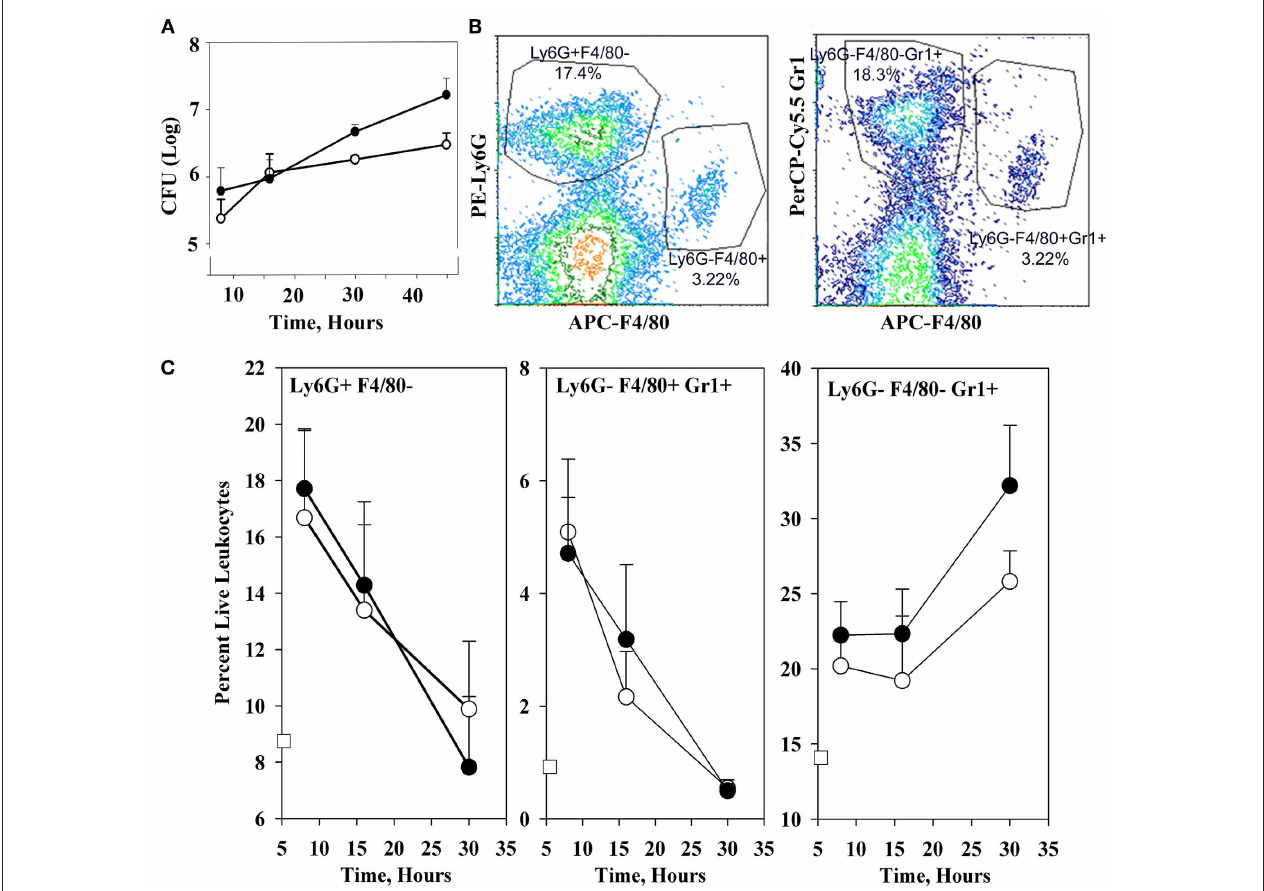
leukocytes changed over 30h of infection for three inflammatory cell types of relevance to the host response to Y. pestis . Values for non-infected mice are given by the open squares on the ordinates. Percentages of Ly6G + F4/80 − PMNs at 16h were significantly different from those at 8h for mice infected with the (cid:2) yopM-1 strain ( P < 0 . 05 by student’s t -test); those at 30h differed significantly from 8h for infections by both Y. pestis strains ( P < 10 − 2 for parent and P < 10 − 4 for (cid:2) yopM-1 ). For Ly6G − F4/80 + Gr1 + MOs, percentagesat both16and 30h differedsignificantly fromthose at 8h for both infections(parent: P < 0 . 05for16h, P < 10 − 5 for30h; (cid:2) yopM-1 : P < 10 − 2 for 16h, P < 10 − 5 for 30h). For the Ly6G − F4/80 − Gr1 + population, percentages differed only for 30 compared to 8h p.i. ( P < 10 − 2 for parent Y. pestis and P < 10 − 3 for (cid:2) yopM-1 ). Each datum point gives the averages ± standard deviation (SD) for pooled data from six mice in two